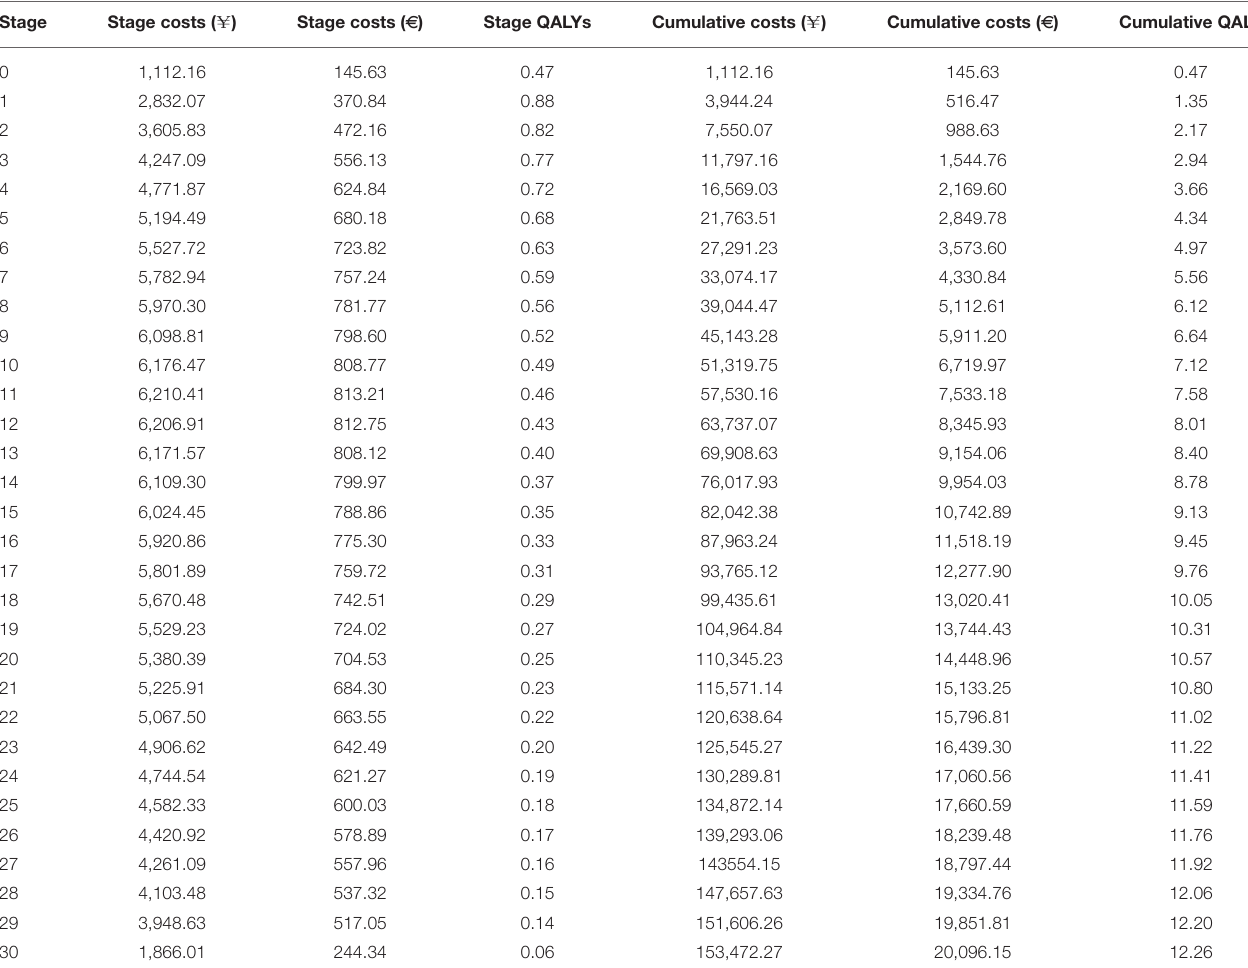
TABLE 5 | Stage costs, stage QALYs, cumulative costs and cumulative QALYs for Dapagliflozin plus standard treatment group.